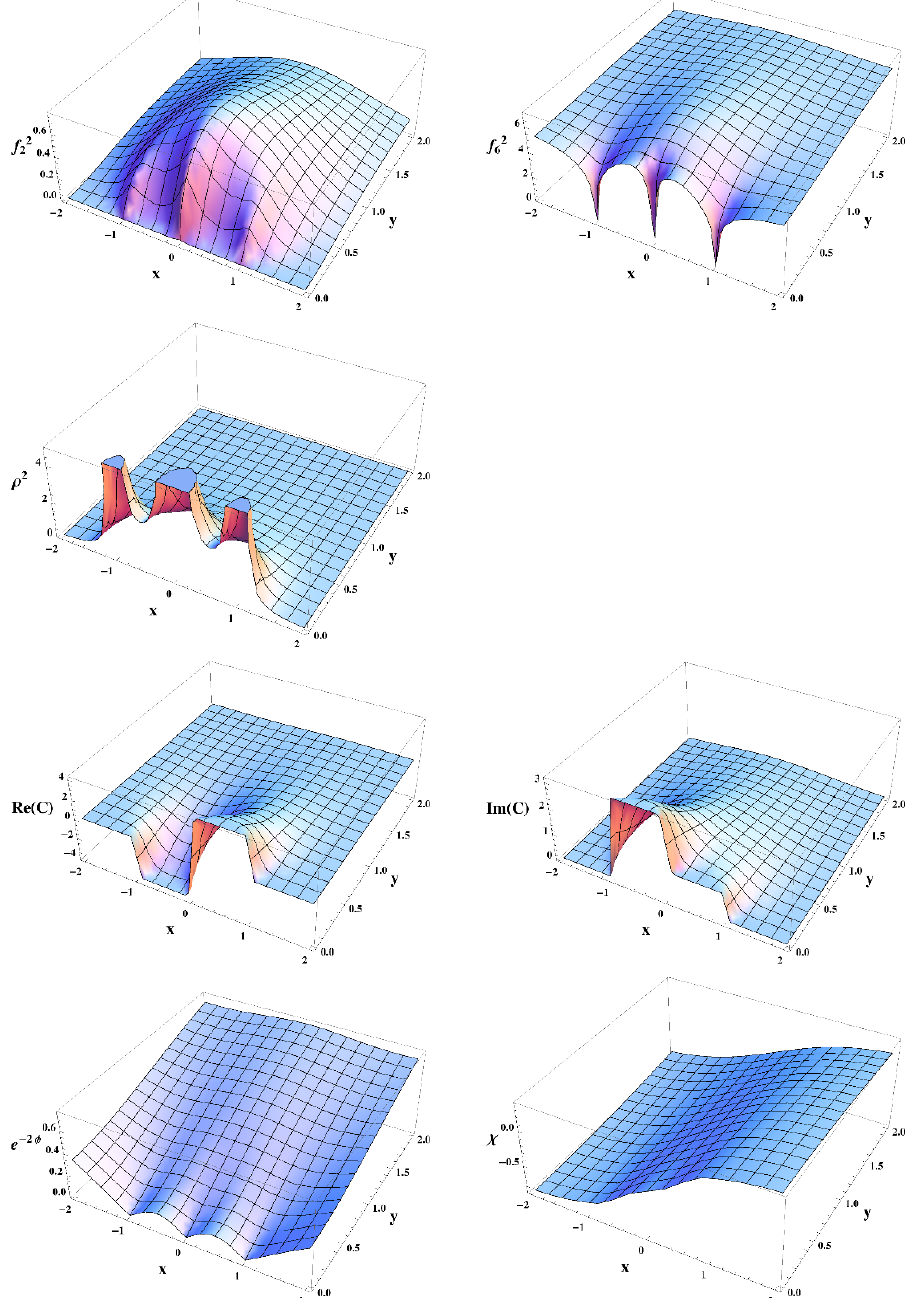
Figure 3 . The three-pole solution: the metric factors f 2 of the two-form potential C and axion and dilaton corresponding to the parameters given in (4.4), as functions of w = x + iy .